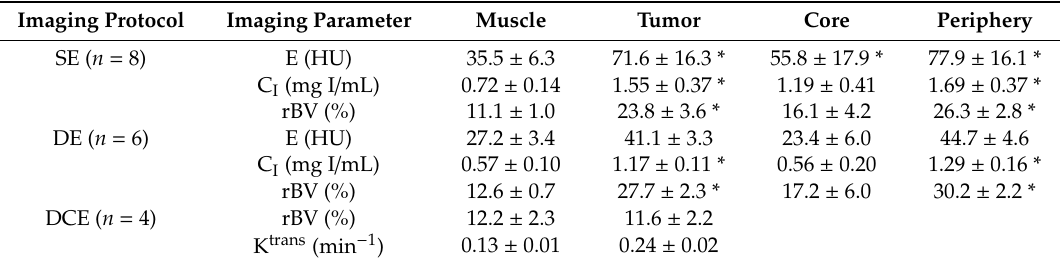
Table 1. Quantitative imaging parameters in muscle and the tumor regions of the subcutaneous C6 glioma model obtained with single-energy (SE), dual-energy (DE), and dynamic contrast-enhanced (DCE)